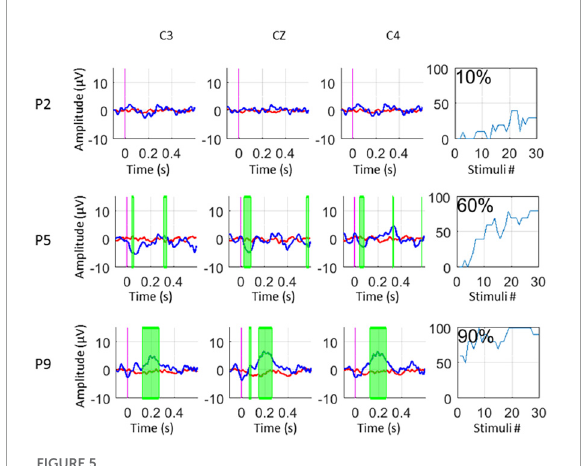
CRS-R administration, suggesting a clinical diagnosis of